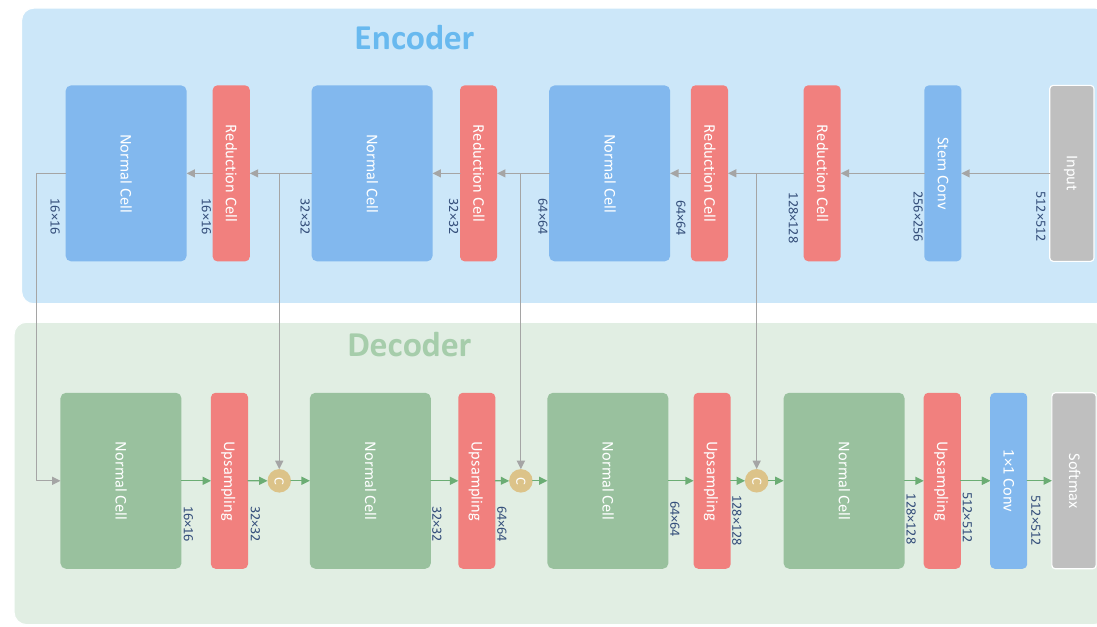
Figure 6. The architecture of the model used for the Inria building dataset. This model, U-NASNetMobile, combines Figure 7. The architecture of the model used for the Inria building data set. This model, U-Net [25] with NASNet [42]. We employ Normal Cells from NASNet as the decoder part of the model. The yellow circles U-NASNetMobile, combines U-Net [25] with NASNet [50]. We employ Normal Cells from NASNet are concatenation layers to combine the different feature maps into a new as the decoder part of the model. The yellow circles are concatenation layers to combine the different feature maps into a new layer.